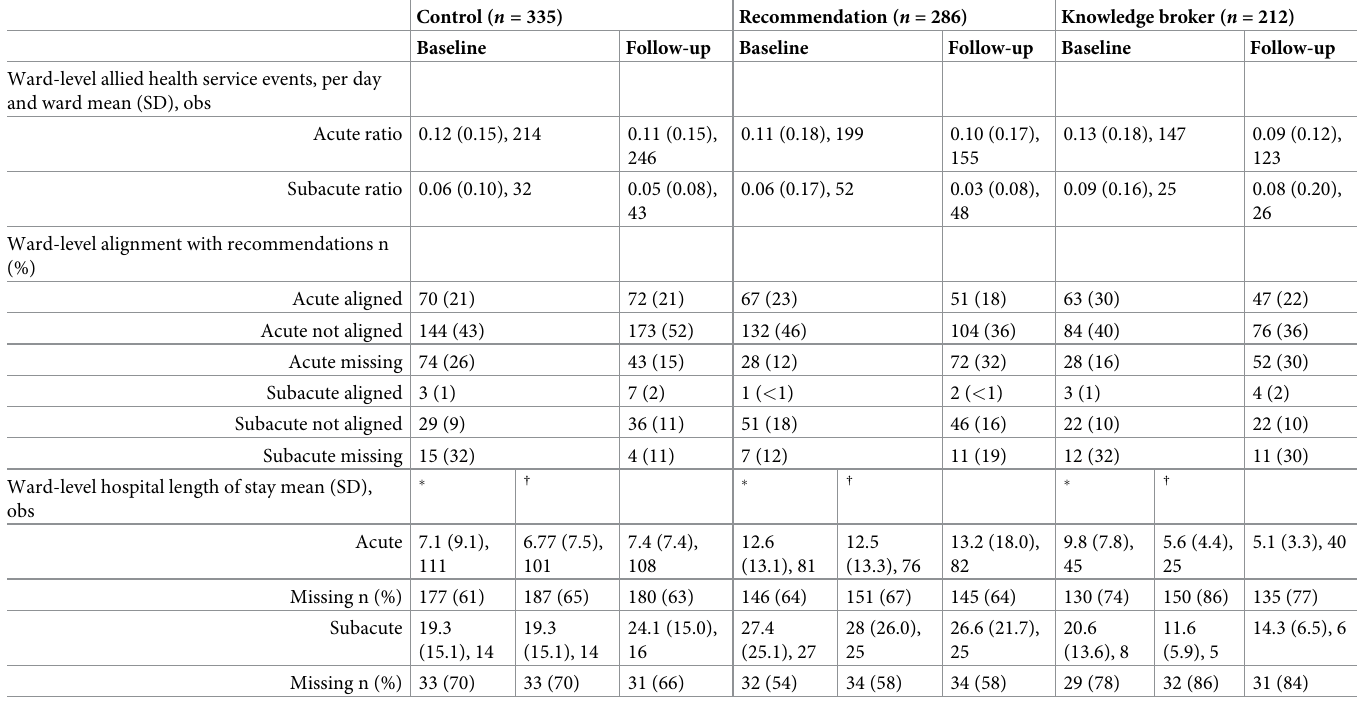
Table 5. Ward-level summative raw data for primary and secondary